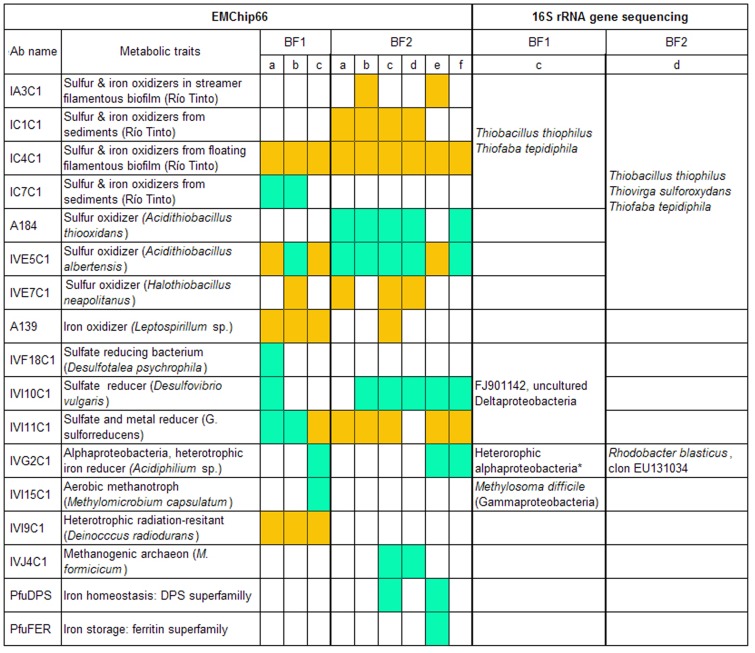
Comparison of EMChip66-deconvoltion results and 16S rRNA gene sequencing.Only antibodies showing positive immunological antigen-antibody interactions in at least one of the transect biofilm samples are listed. Type I antibodies: their cognate antigen is not present in the sample (white squares). Type II antibodies: their cognate antigen is not present in the sample, but a closely related antigen is present (orange squares). Type III antibodies: either their cognate antigen or a closely related one is present in the sample (green squares). Some of the 16S rRNA genes sequences obtained from BF1c and BF2d confirm the results obtained by deconvolution method. * Parvularcula sp., Hyphomonas sp., Stappia sp., Porphyrobacter sp.